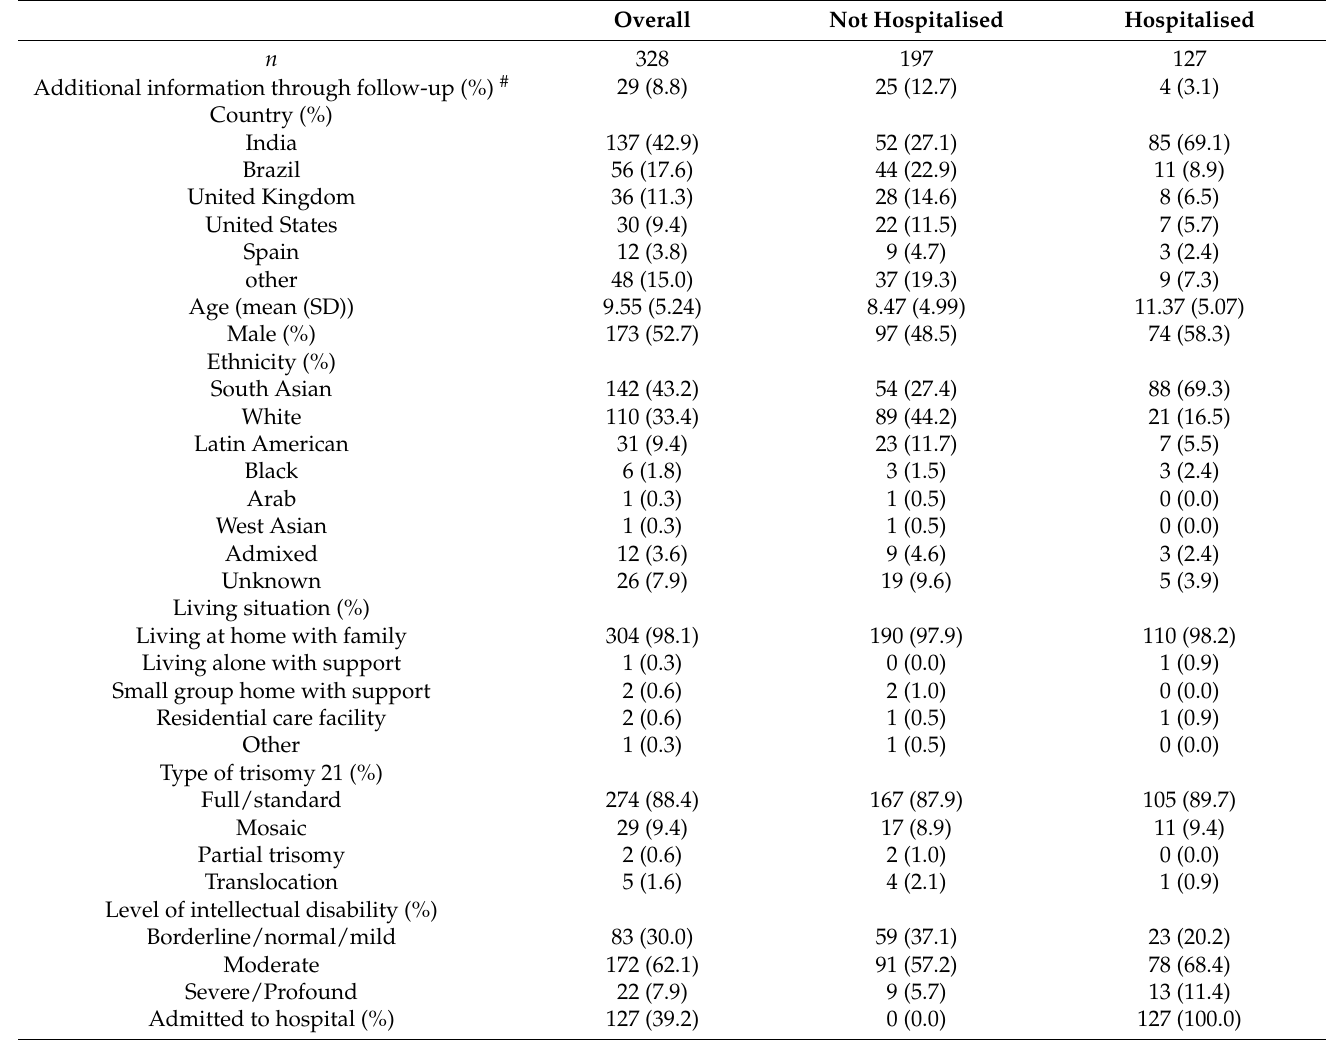
Table 1. T21RS study characteristics grouped by hospital admission. Overall Not Hospitalised